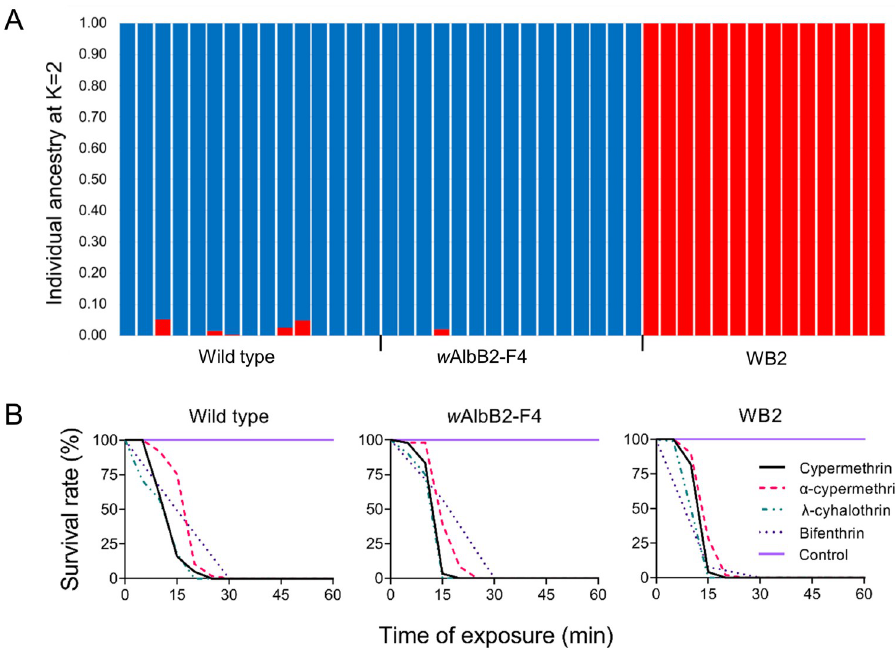
Fig 4. Analysis of genetic equivalency of w AlbB2-F4 strain to Australian Aedes aegypti . (A) All mosquitoes from the w AlbB2-F4 strain have > 98% ancestry (Q-values) from the Australian wild-type strain (and not the WB2 strain), indicating a successful backcrossing procedure. (B) The Wolbachia infected Aedes aegypti w AlbB2-F4 strain has equivalent insecticide susceptibility to the parental Queensland wild type mosquitoes and Ae . aegypti w AlbB2 strains. Survival rates of mosquitoes were recorded following exposure to diagnostic doses of alpha-cypermethrin, cypermethrin and lambda-cyhalothrin using CDC bottle bioassays. Survival rates following exposure to a diagnostic dose of bifenthrin were determined using WHO filter paper